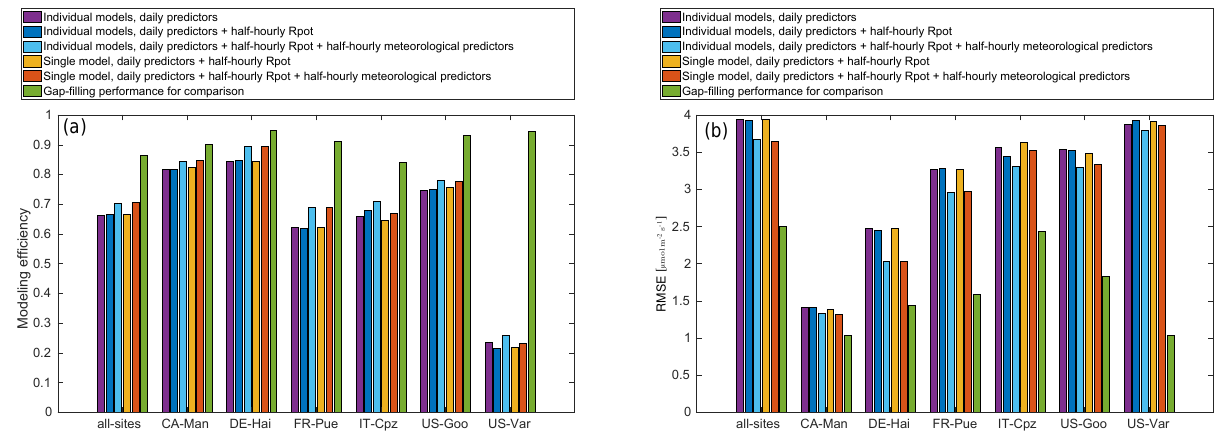
Figure 5. Prediction performances ( a modeling efficiency; b RMSE in µmolm − 2 s − 1 ) for individual half-hourly values of GPP depending on different sets of predictor variables are shown. We compare our two proposed prediction approaches (individual RDF models and single RDF model) and also include the results of a gap-filling algorithm for comparison. Looking at the results of all sites as well as at site- specific performances, we observe that meteorological predictor variables at half-hourly resolution clearly improve the accuracies of the estimations. Site acronyms: Canada Manitoba Black Spruce (CA-Man), Germany Hainich (DE-Hai), France Puechabon (FR-Pue), Italy Castelporziano (IT-Cpz), USA Mississippi Goodwin Creek (US-Goo), USA California Vaira Ranch